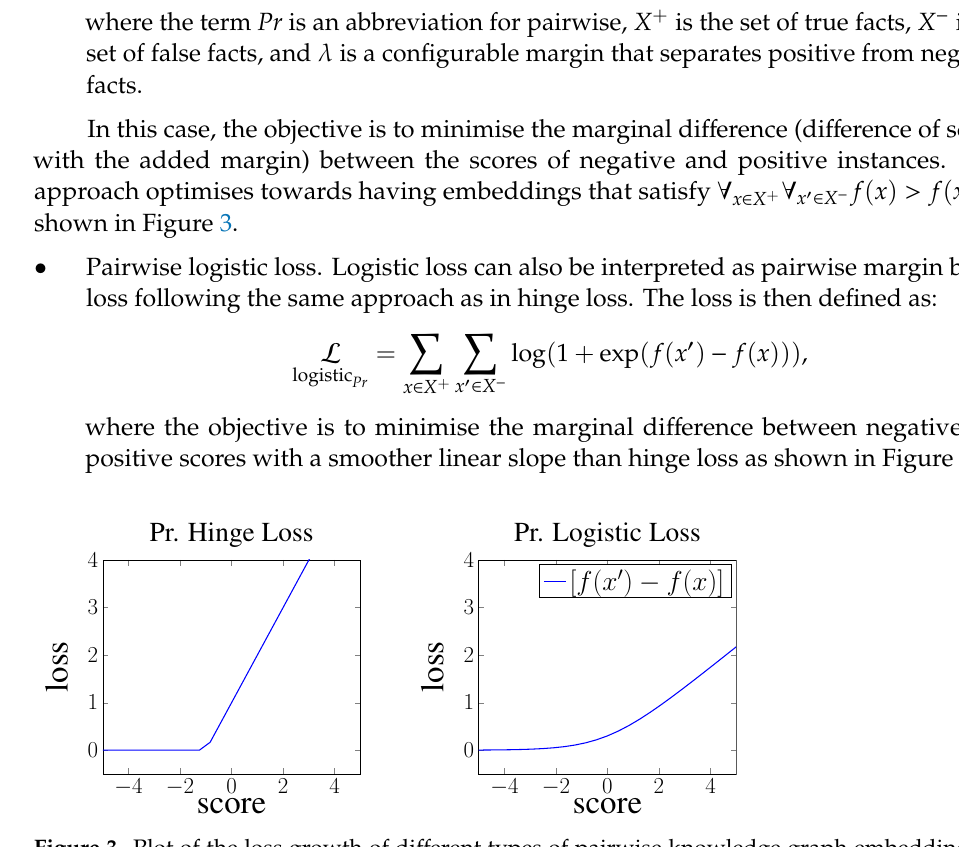
Figure 3. Plot of the loss growth of di ff erent types of pairwise knowledge graph embedding loss functions. The term Pr. is an abbreviation for